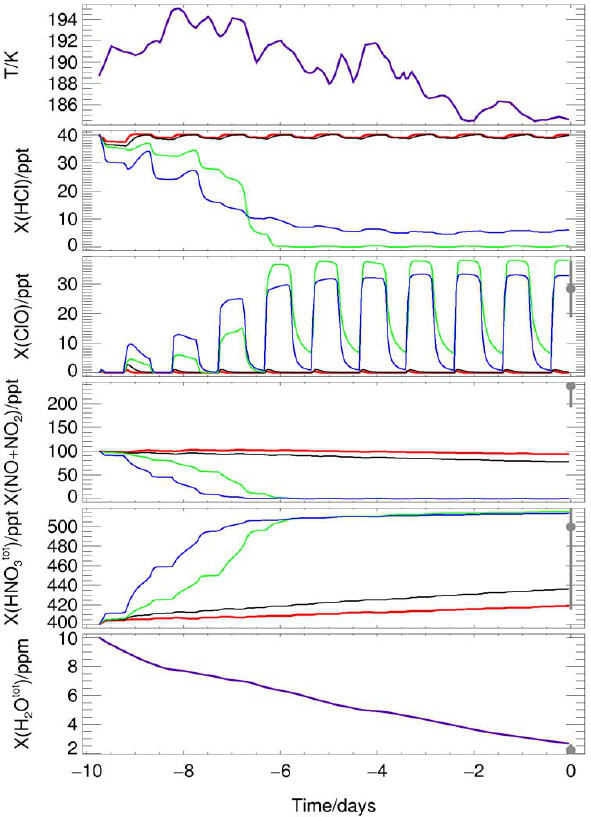
Fig. 8. CLaMS BT simulation results for the flight on 19 Novem- ber 2005 for various parameters along a chosen back-trajectory end- ing on the flight path at 05:51UTC, i.e. in the time window where chlorine activation was observed by HALOX for different initiali- sations: Red: 1ppt Br y /50ppb O 3 ; black: 1ppt Br y /125ppb O 3 ; green: 1ppt Br y /200ppb O 3 ; blue: 5ppt Br y /125ppb O 3 . Corre- sponding observations at the trajectory endpoints are shown in grey. The observed x (O 3 ) was ∼